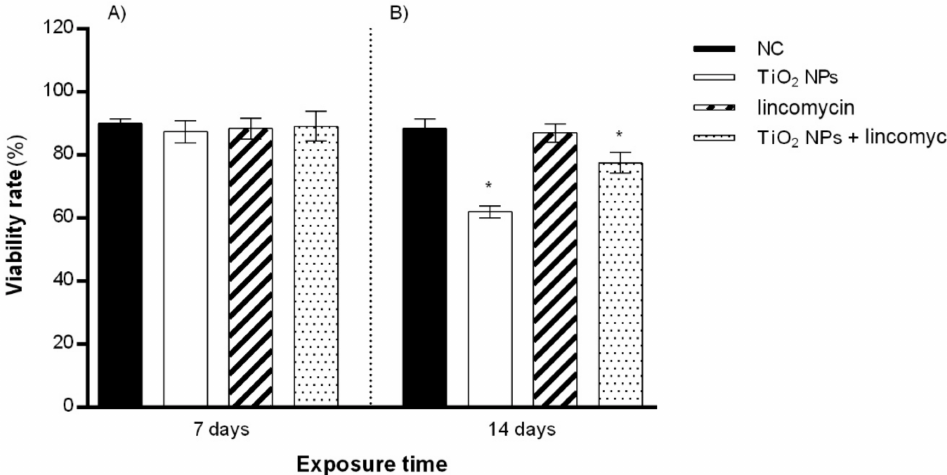
Figure 2. Percentage of live zebrafish blood cells (ordinate) after 7 days of exposure ( A ) and after 14 days of exposure ( B ) to TiO 2 NPs alone, lincomycin alone, and TiO 2 NPs and lincomycin in combination (abscissa). The dark bars are the negative control (NC); the white bars are 10 µ g/L TiO 2 NPs-treated specimens (TiO 2 NPs); the striped bars are 100 mg/L lincomycin treated specimens (lincomycin); and the dotted bars are 10 µ g/L TiO 2 NPs + 100 mg/L lincomycin treated specimens (TiO 2 NPs + lincomycin); * p ≤ 0.05 in comparison with the